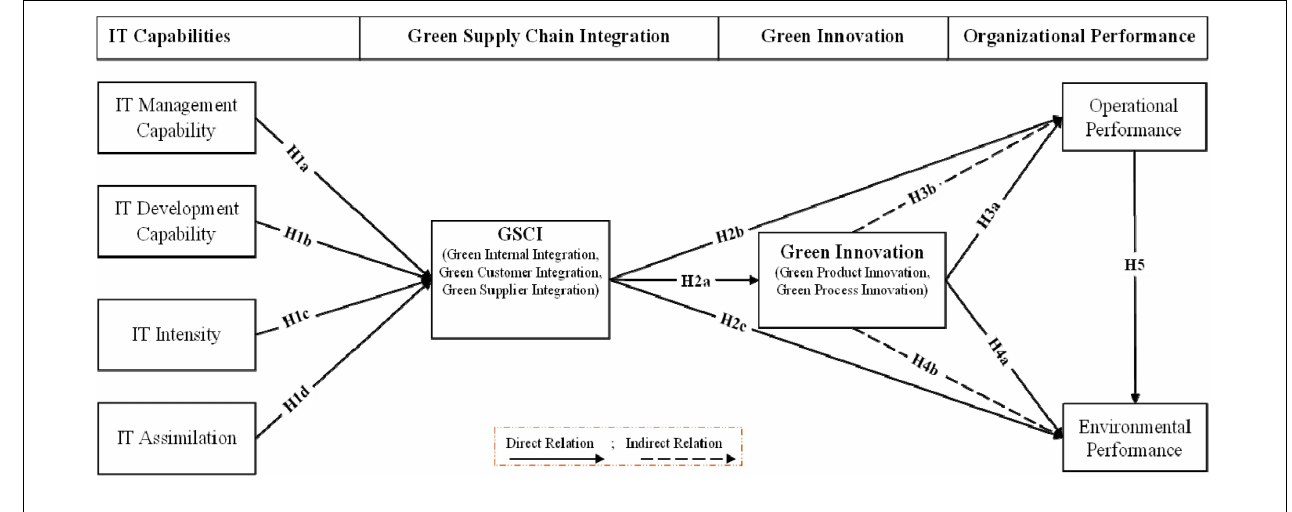
FIGURE 1 | Proposed model.